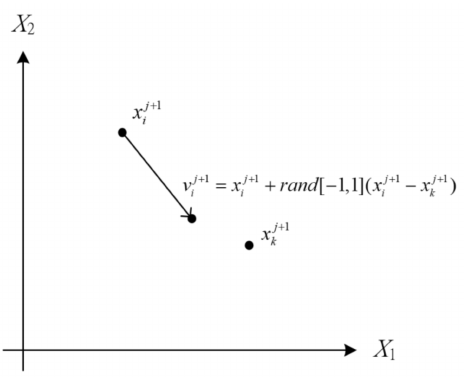
Figure 2. Two-dimensional schematic diagram of the movement of employed bees.